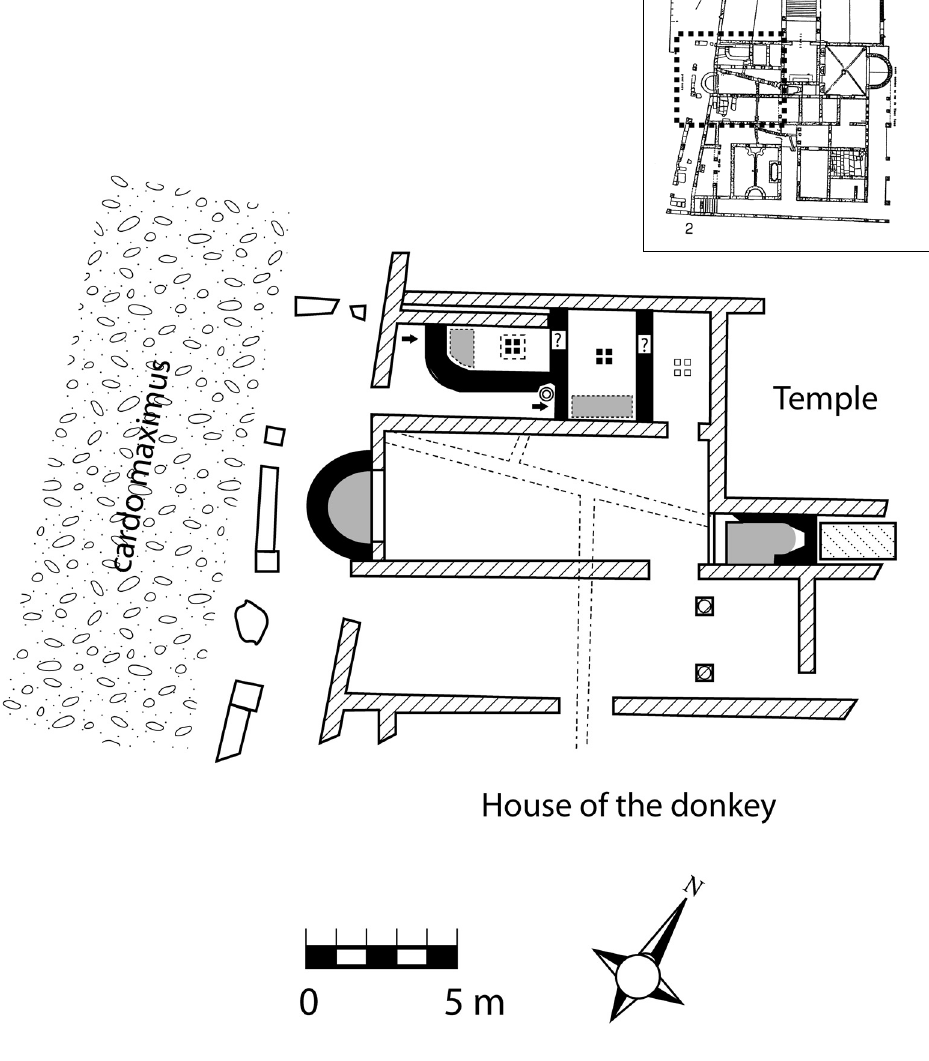
Figure 3: The baths of the House of the Donkey in Cuicul (after Blanchard-Lemée 1978: 24, fi g. 4).